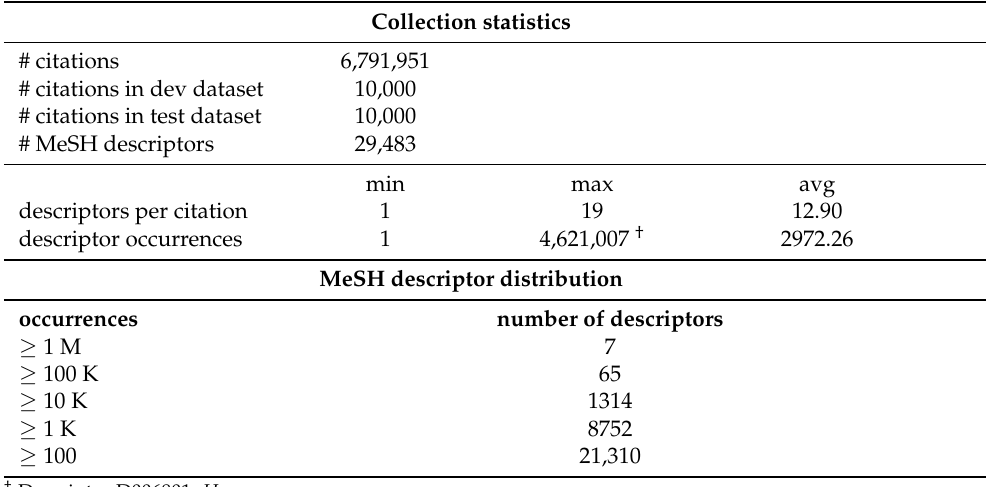
Table 2. Evaluation dataset statistics and MeSH descriptor